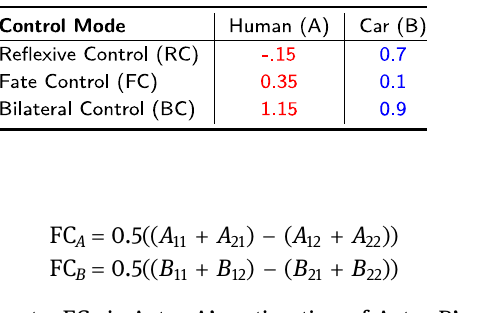
Table 1: Summary of Interdependence control modes from the human - robot interaction example based on normalized payo ff